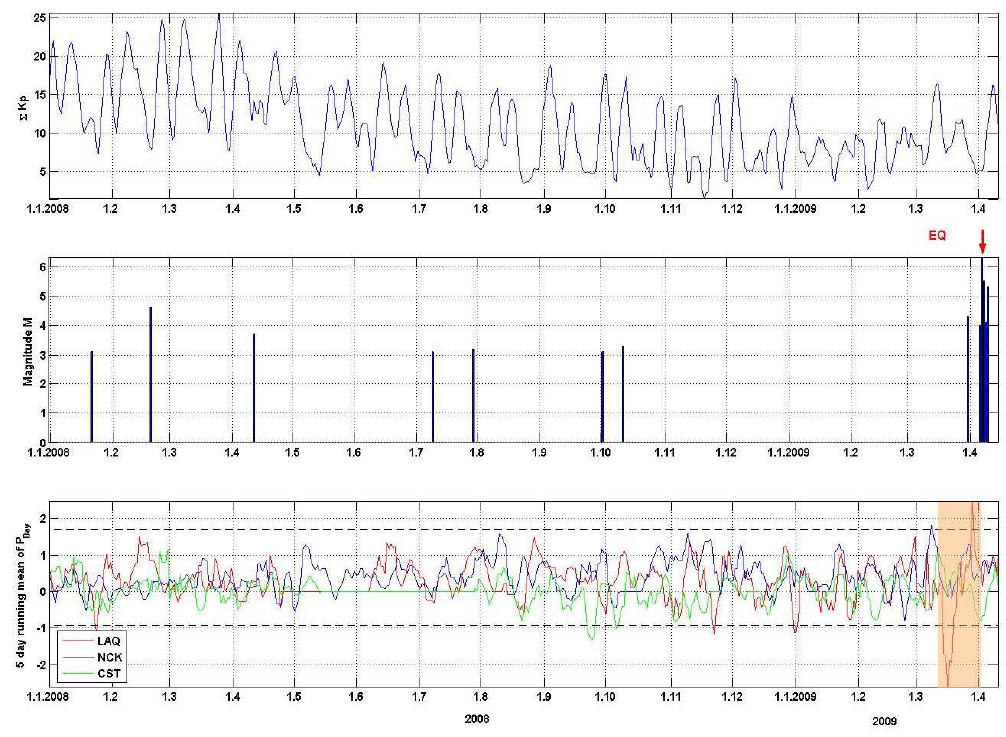
Figure 4 Fig. 4. Five day running mean of P K p , magnitude of the seismic events with the earthquake swarm in April 2009, and standardized polarization from 1 January 2008 to 14 April 2009 for CST, NCK, and LAQ station. LAQ station shows anomalies above and below 2 σ eleven days prior the impending earthquake series. The earthquake series main stroke is indicated with an arrow in the second